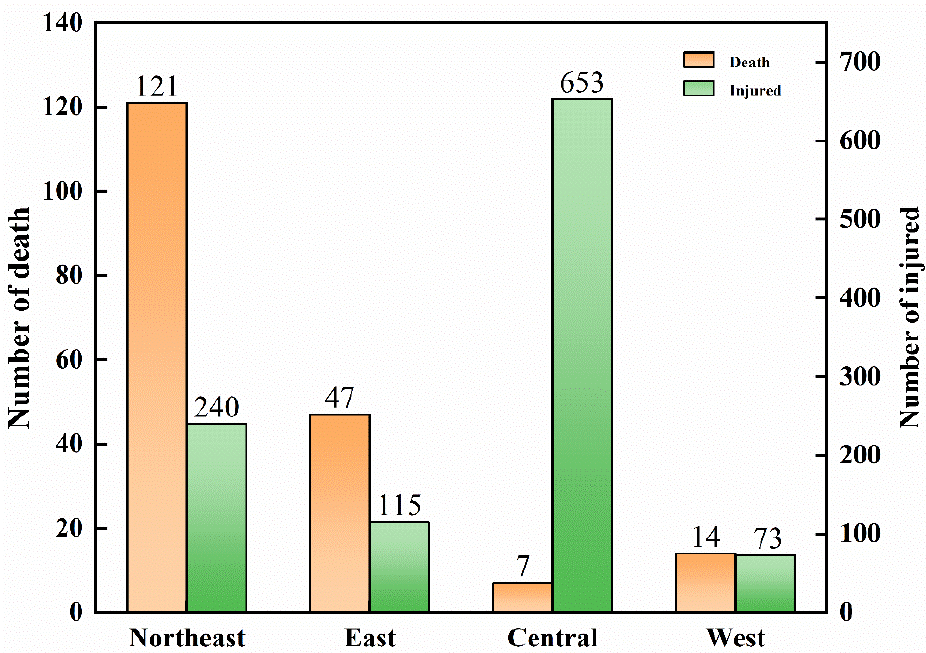
Figure 8. Number of deaths and injured in four economic zones.